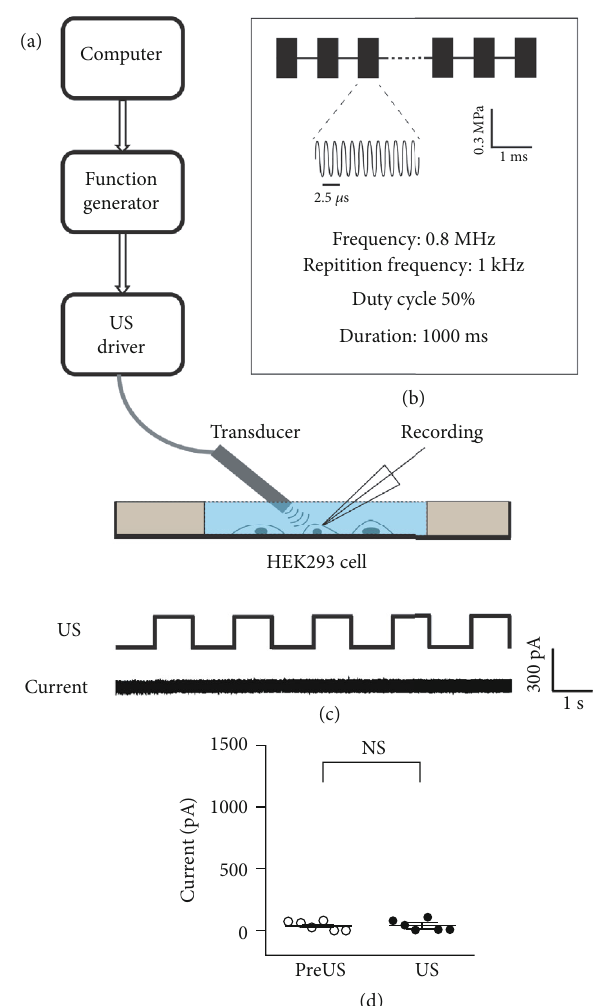
Figure 1: The ultrasound stimulation system and the patch clamp recording of cultured cells. (a) A schematic illustration of our combined recording and ultrasound system. The response to ultrasound stimulation of a single HEK293 cell was measured. (b) A schematic illustration of the pulsed waves of ultrasound stimulation, with an acoustic pressure of 0.3MPa, 1 kHz repetition frequency, and 50% duty cycle. (c) US stimulation did not elicit changes in the membrane current of a representative HEK293 cell. (d) The mean current amplitude before and during US stimulation. Data are presented as the mean ± SE . NS: no statistic di ff erence, p > 0 : 05 , n = 7 , paired t